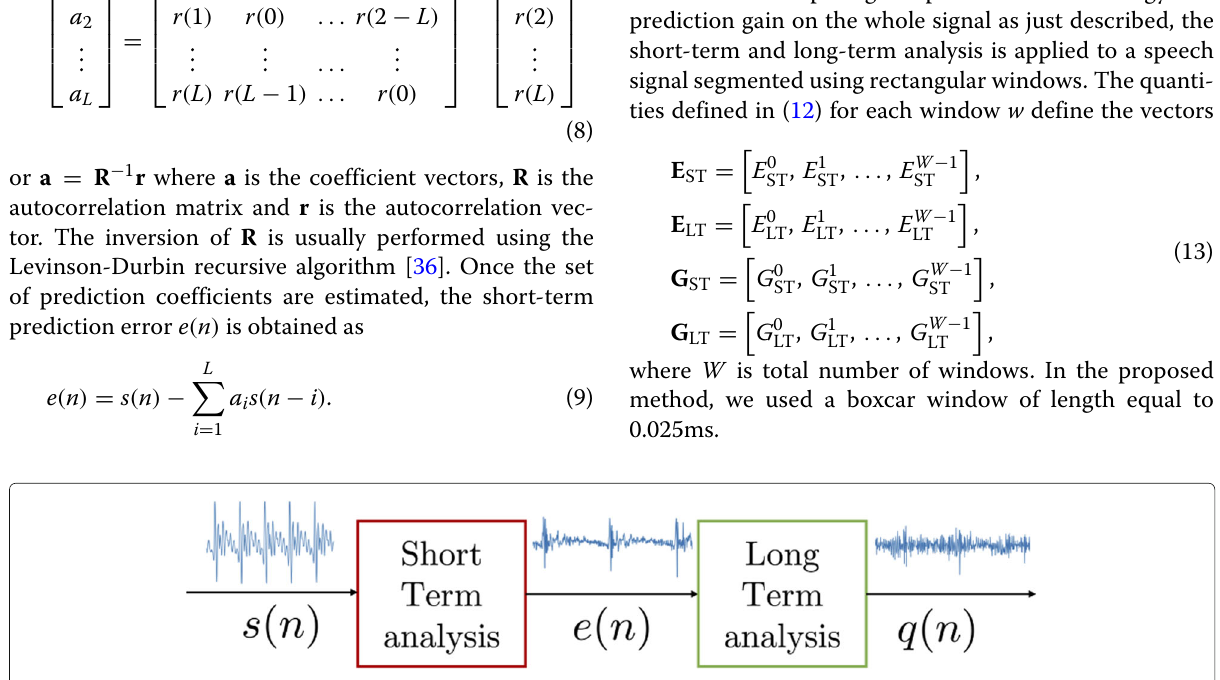
Fig. 2 STLT feature extraction. In this figure, s ( n ) is the speech signal, e ( n ) is the source excitation signal, and q ( n ) is the wide-band noise